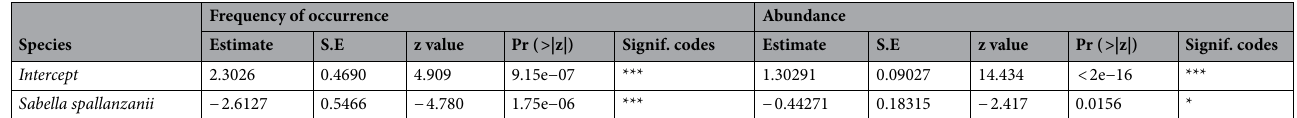
Table 2. Estimates, standard error (S.E.), z-value and p -values with significant code (*) of Generalized Linear Models (GLM) analysis to assess differences in microplastics ingested by Sabella spallanzanii and